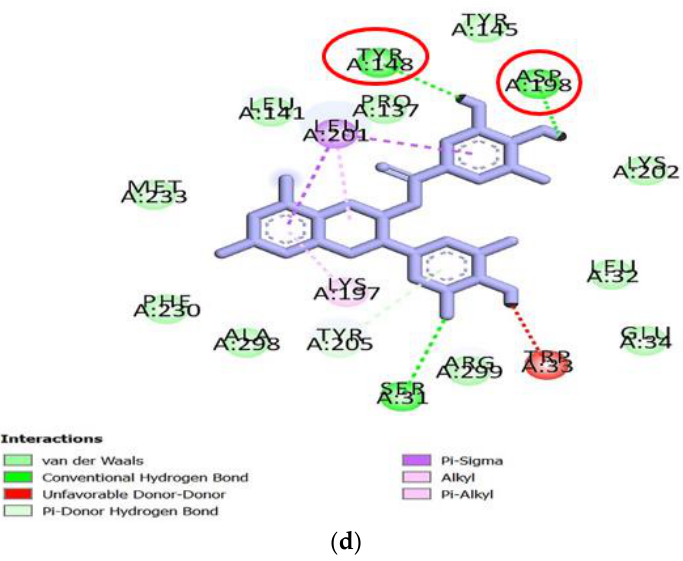
Figure 4. 2D diagram of top three predicted ligands from Gardeniae fructus and the positive control with 5NX2. Hydrogen bonds (green circles with traced lines), π-Alkyl interactions (pink circles with traced lines) and π-Sigma interaction (purple circles with traced lines). ( 1 ) Stigmasterol, ( 2 ) 3-epioleanolic acid, ( 3 ) crocin and ( 4 ) EGCG. The key residues in common between EGCG and the three ligands have been circled in red and discussed in the text.